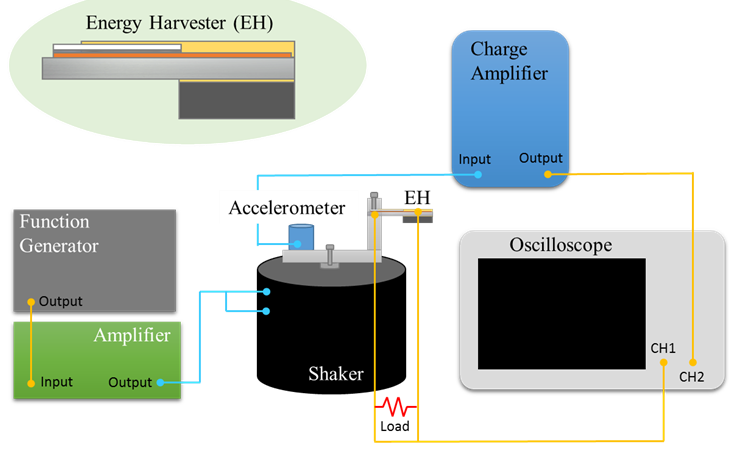
Figure 3. Schematic illustration of the experimental setup for the piezoelectric MEMS